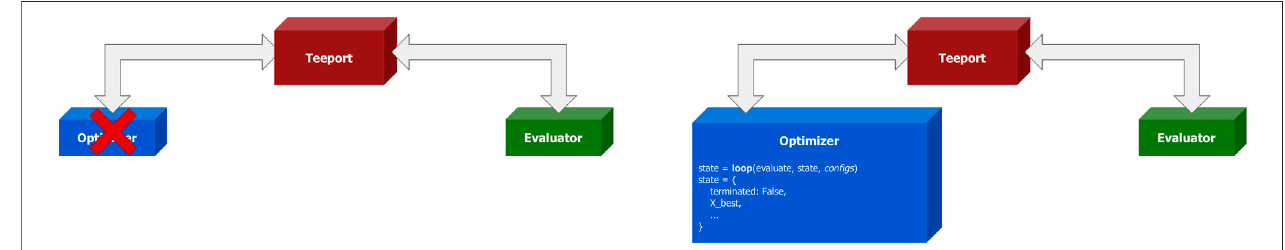
FIGURE10| BreakpointrecoveryinTeeport.Left:Theoptimizercrashesinthemiddleofoptimization,whichbreaksthewholeoptimizationprocess;Right:Aloop- basis optimizer could recover the optimization from the breakpoint.